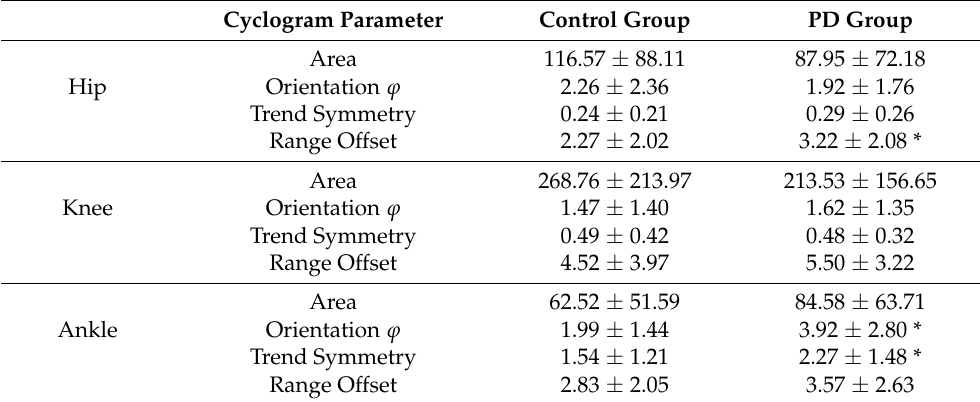
Table 6. Comparison between symmetry indexes of PD and CG subjects. Values are expressed as mean ± SD.